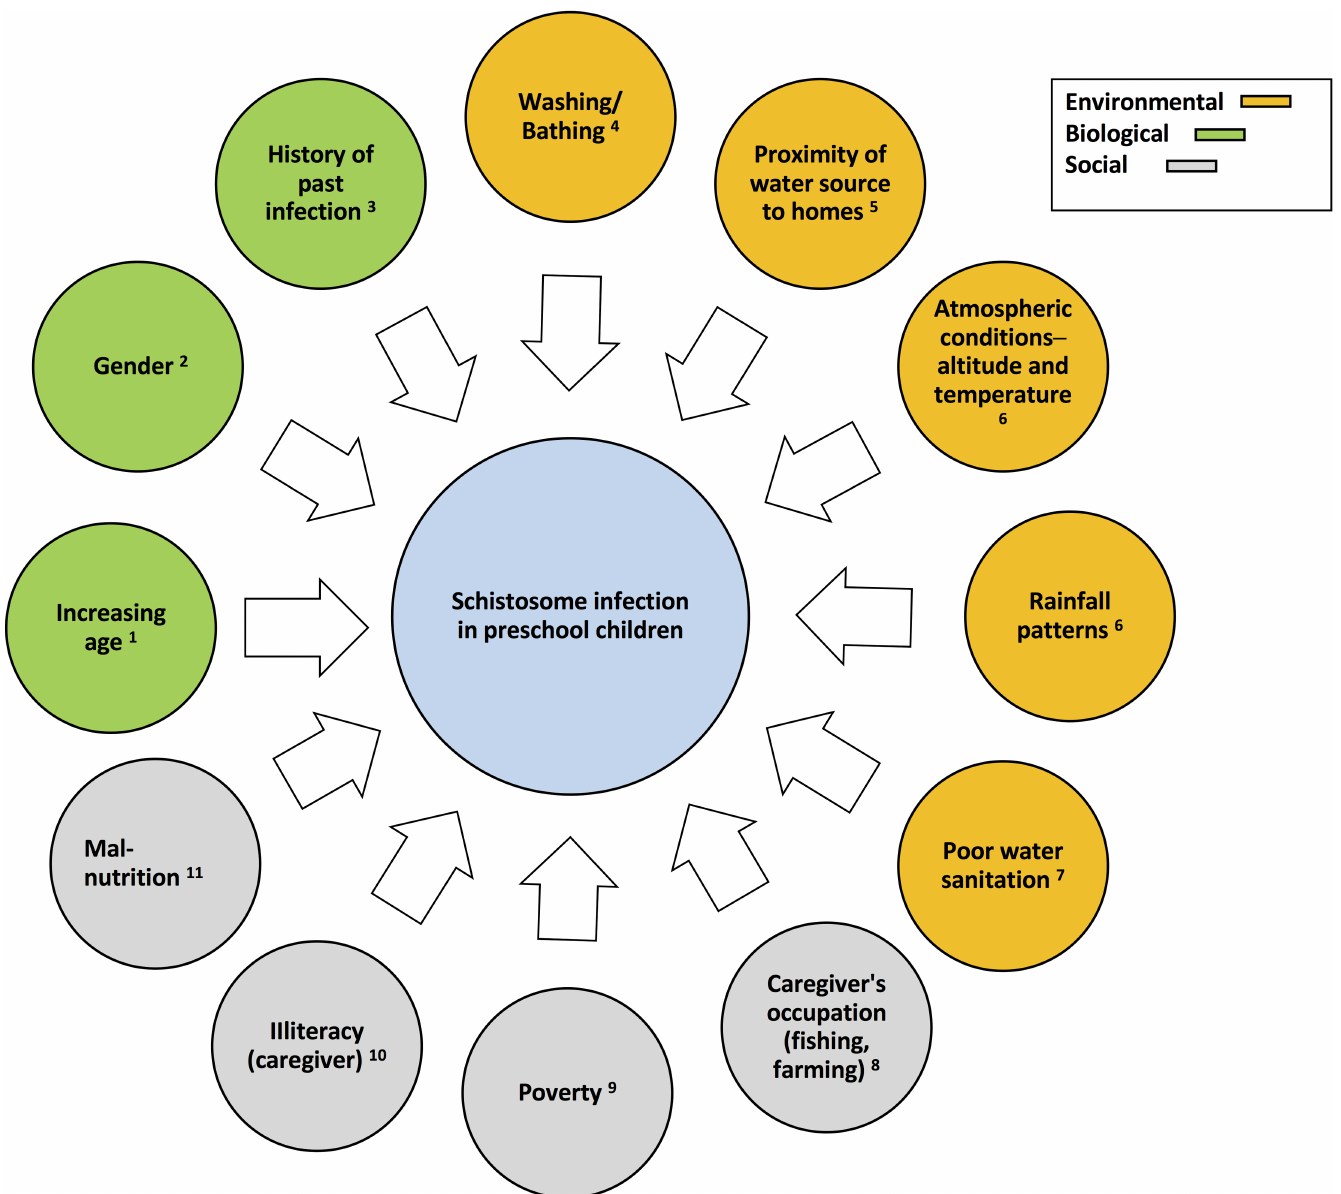
Fig 1. Risk factors for schistosome infection in PSAC. Adapted from : 1 [14]; 2 [14, 15]; 3 [16]; 4 [15], 5 [15, 17, 18]; 6 [13, 14]; 7 [19]; 8 [14]; 9 [18]; 10 [20]; 11